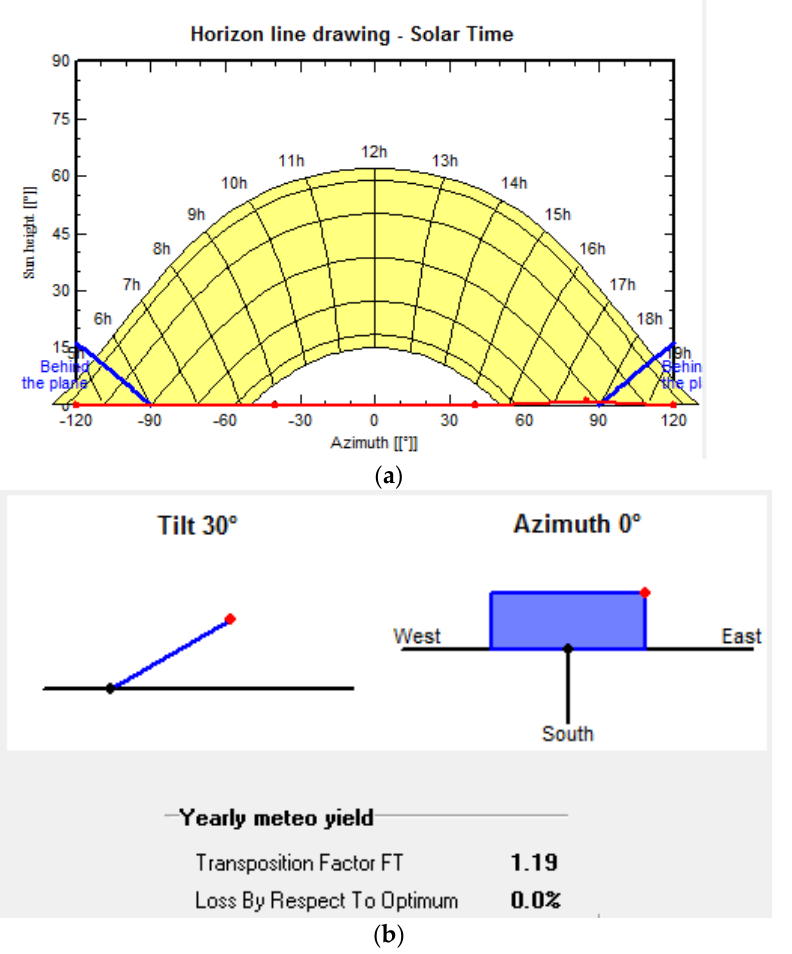
Figure 4. Simulation of harvested solar radiation with a 30-degree glass angle based on the PVSyst simulation: ( a ) solar radiation potential; ( b ) title of system efficiency.